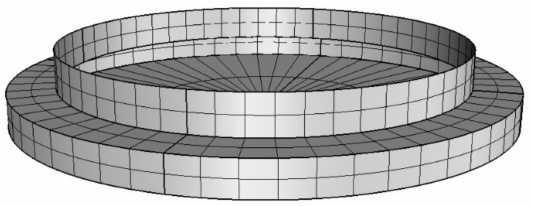
Figure 5. High order mesh considered in the WAMIT code analysis.